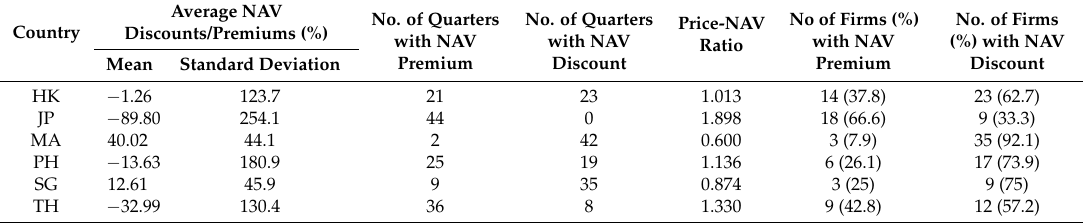
Table 1. Average quarterly performance of net asset value discounts/premiums and Price–NAV Ratios of Asian securitized real estate markets: 2004Q1 to 2014Q4.